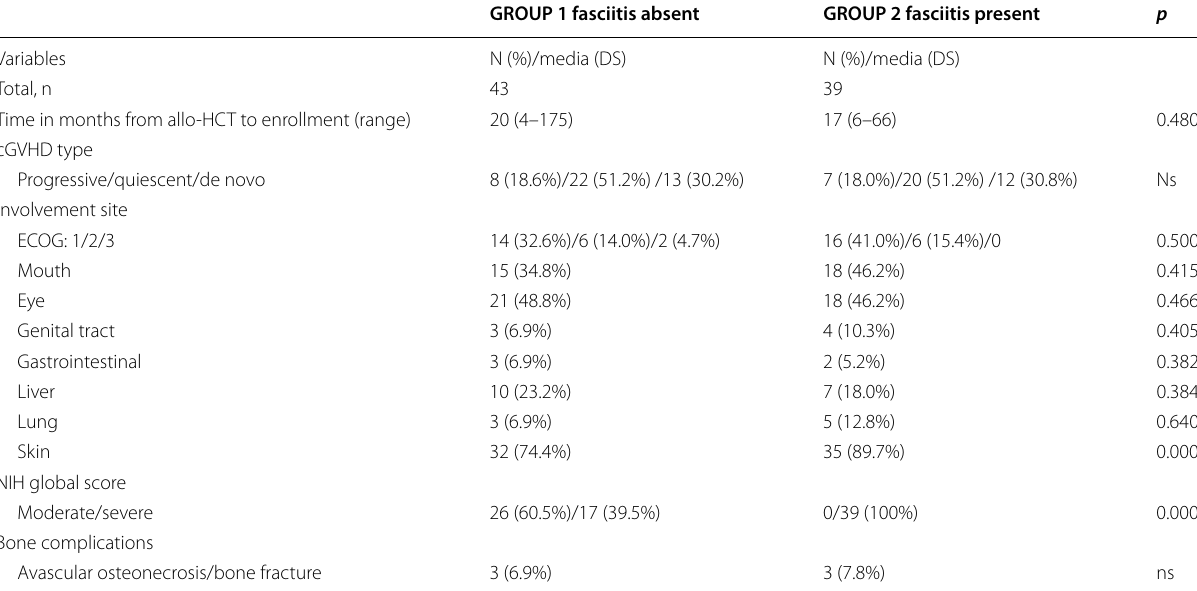
Table 3 Clinical assessment of chronic GVHD